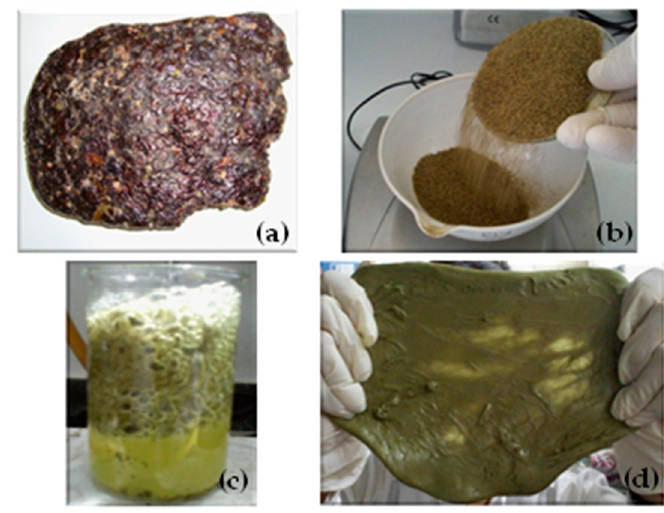
Figure 1. Mopa-Mopa resin: ( a ) in the raw state; ( b ) after the grinding process; ( c ) during the separation process; ( d ) after the extraction process.